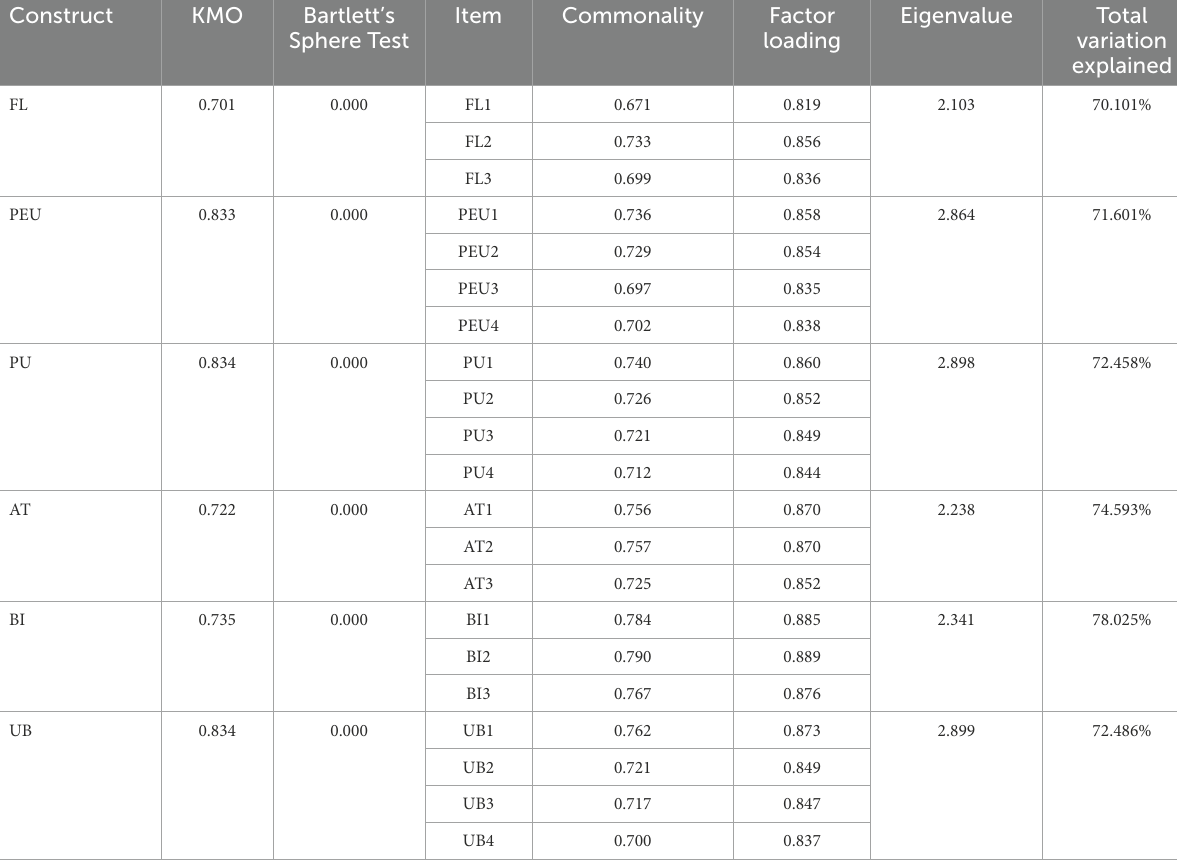
TABLE 6 Results of the exploratory factor